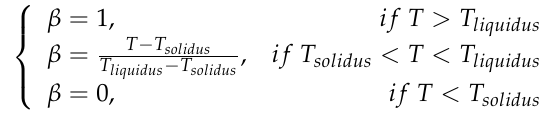
Figure 1. The MEMS system is surrounded by an air box, in which all the magnetic flux lines are closed. Boundary conditions are assigned on this box surface: zero tangential H field. This boundary condition is applied to the external boundaries of the calculated domain, the H field of which is normal to the assigned